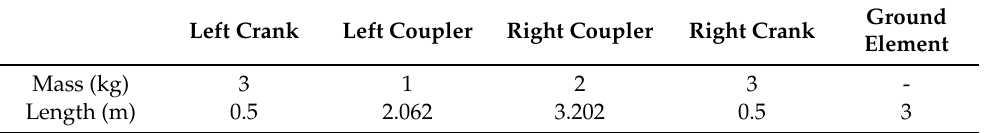
Table 2. Properties of the five-bar